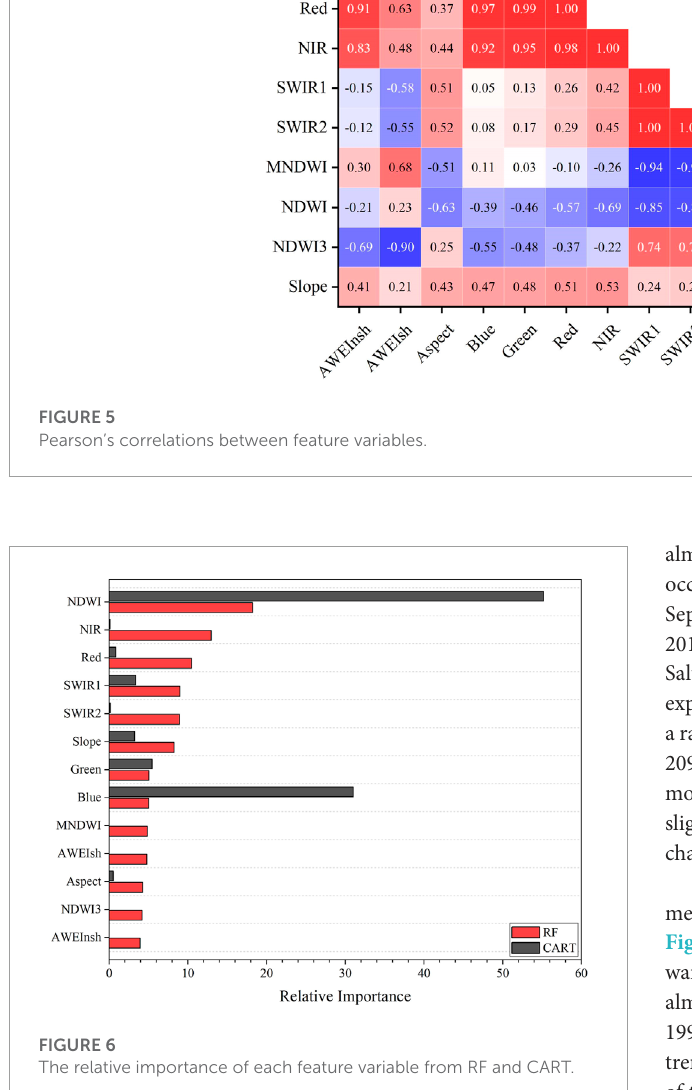
to be the least important feature